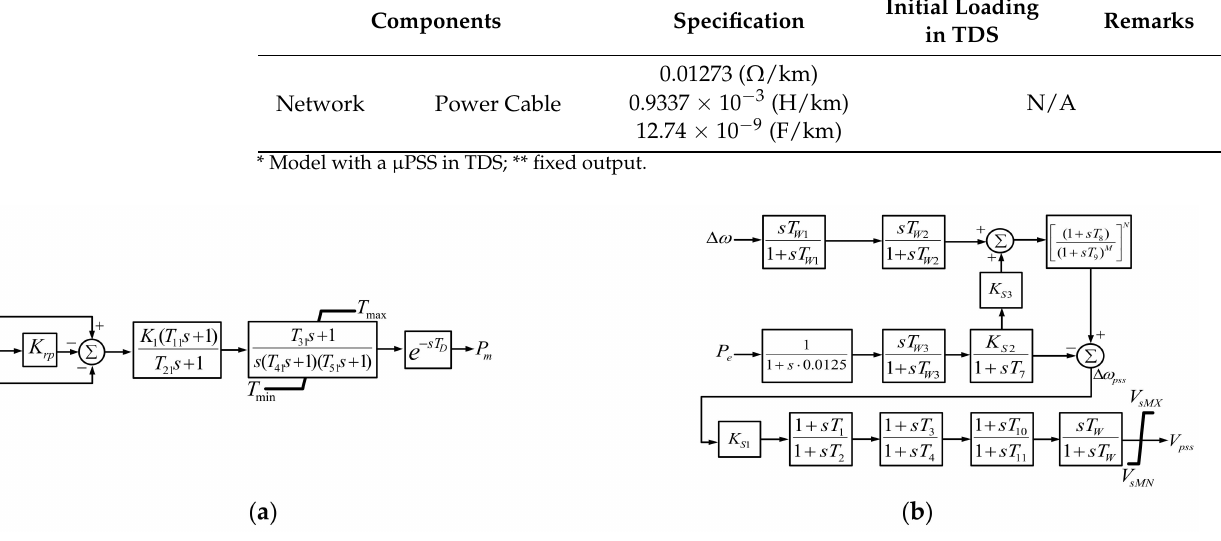
Figure A1. Simulation model: ( a ) governor model and ( b ) PSS-2B model.